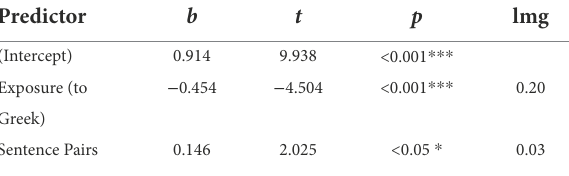
TABLE 7 Final model for the English GJT.